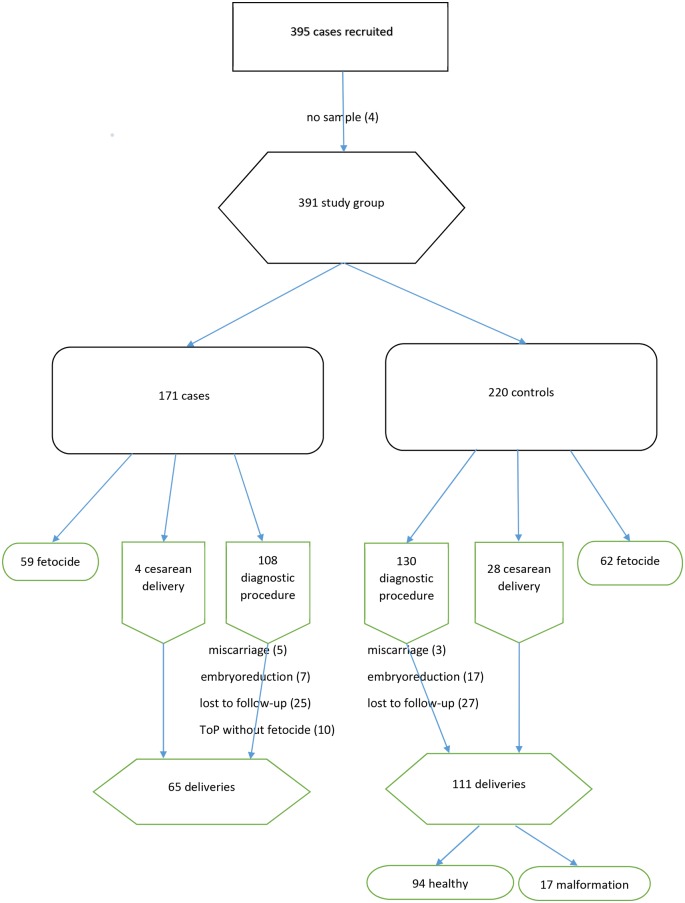
Study flow diagram.